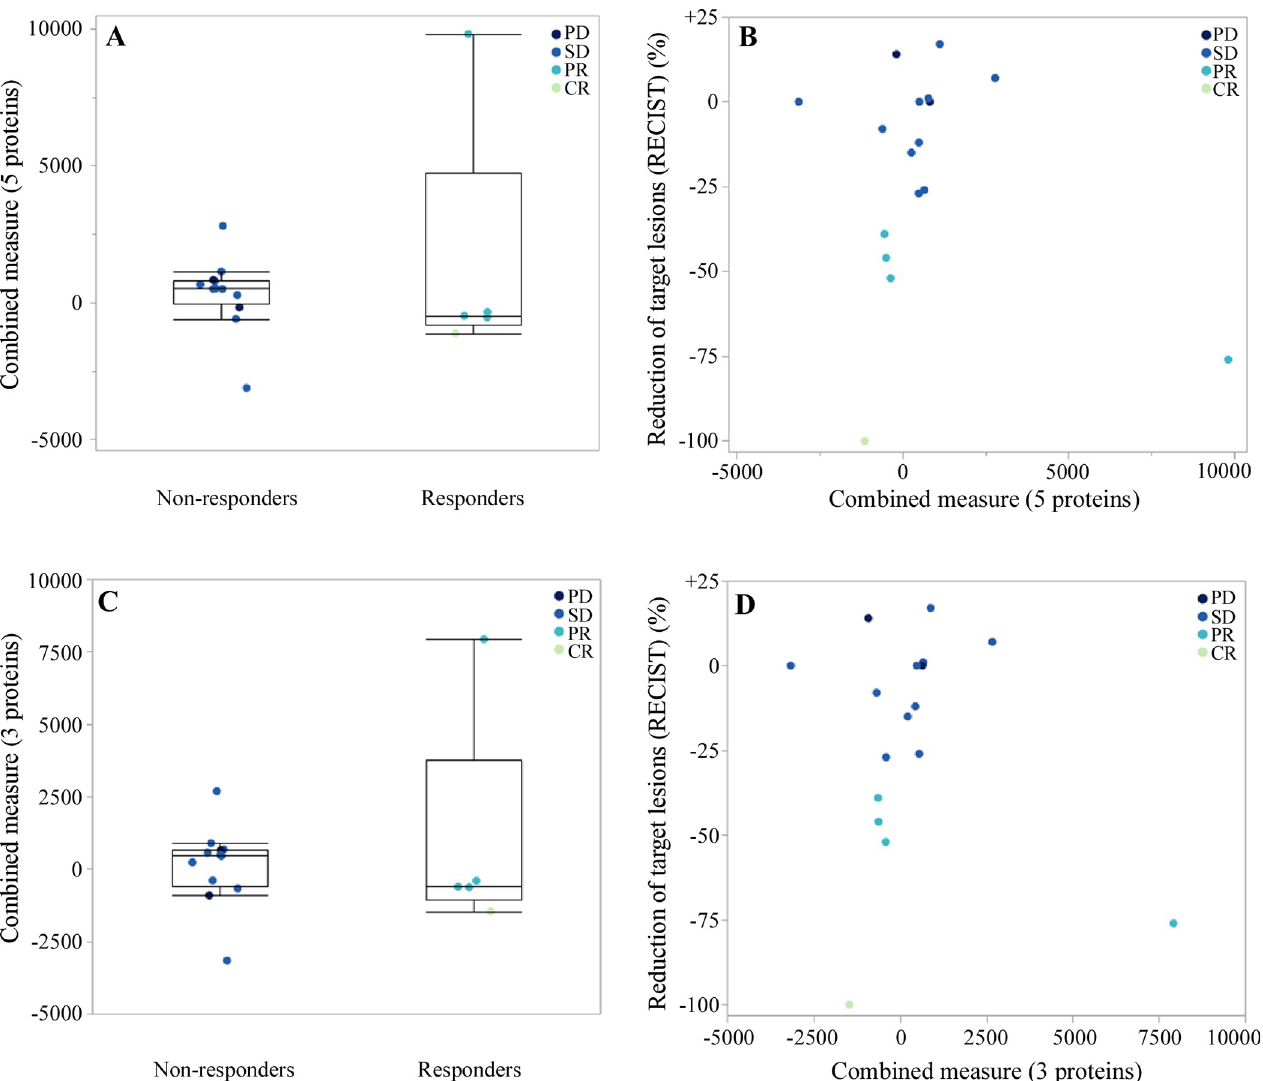
Fig 4. Box plot representations and correlation of the 5- and 3-protein signatures with patient response. (A, C): Box plot representations of the 5-protein (A) and the 3-protein (C) signature separated by patient response; the box plots data distribution includes minimum, first quartile, median, third quartile, and maximum. (B, D): Correlation of the 5-protein (B) and the 3-protein (D) signature to the individual patient response assessed by RECIST; the signatures’ combined measure is obtained by summing the concentration of the proteins CLIC3+GM2A+OAT+PADI3-DPYSL2 (5-protein signature) or GM2A +OAT-DPYSL2 (3-proteins signature). PD: progressive disease; SD: stable disease; PR: partial response; CR: complete response.